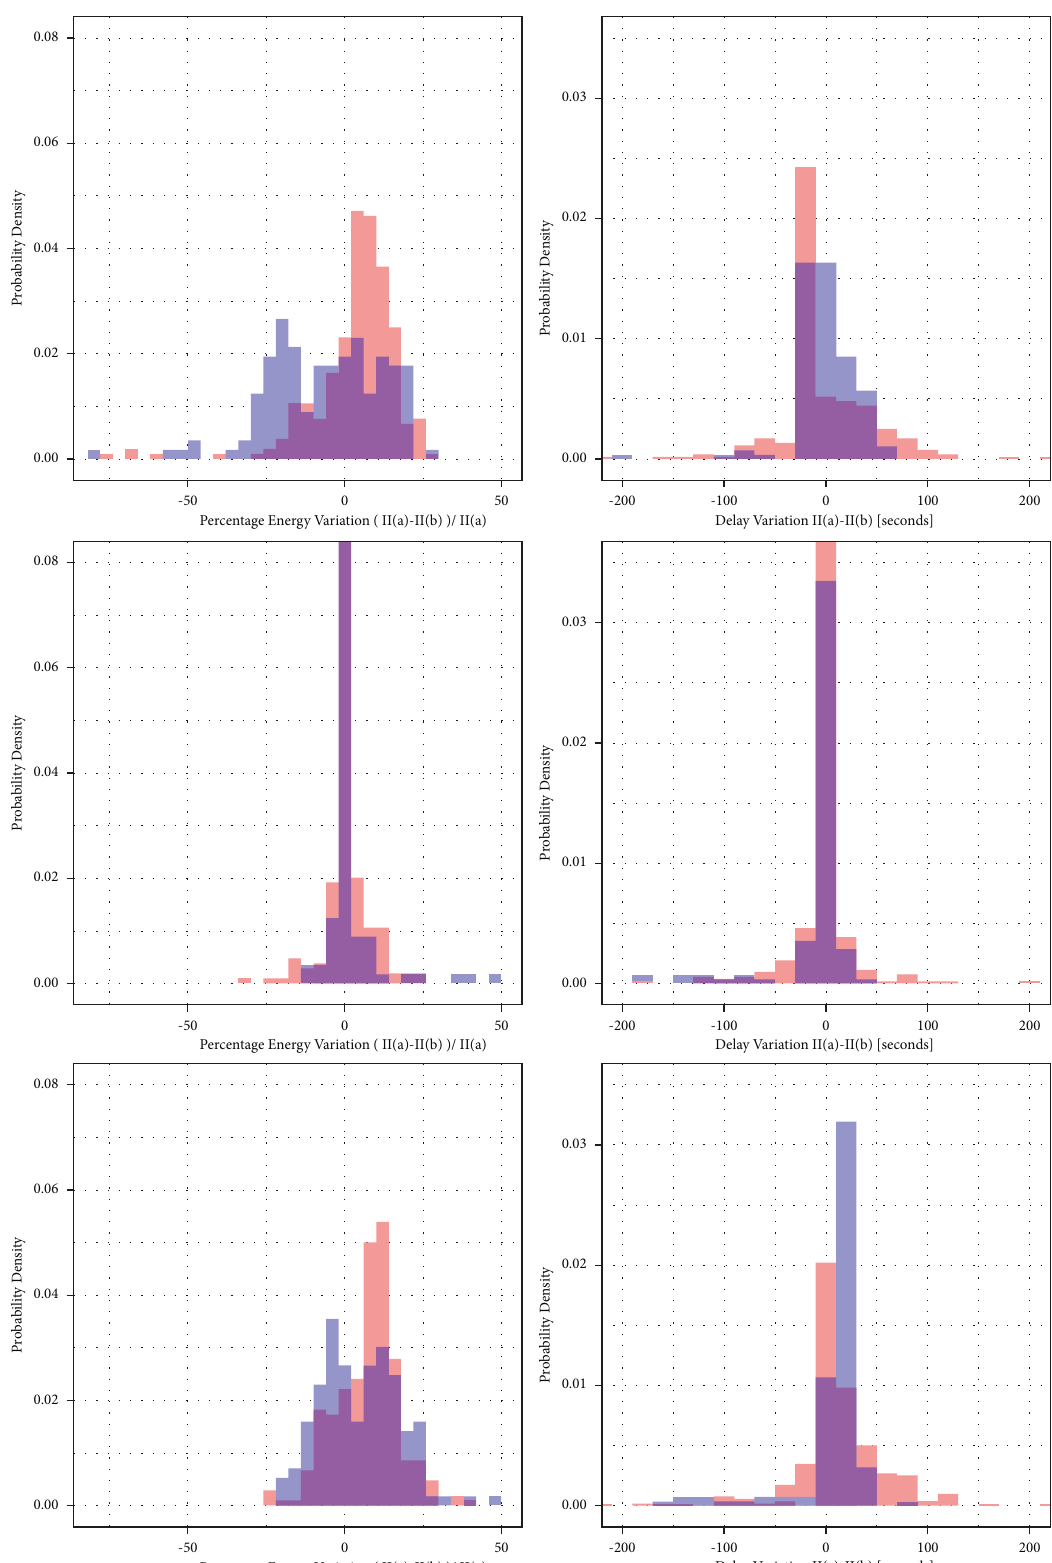
Figure 7: Analysis of Scenario II by energy/delays, based on train